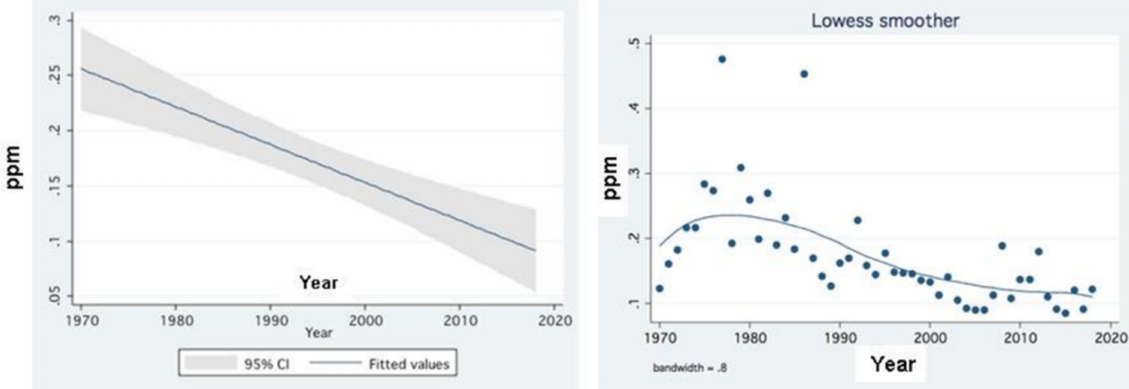
Figure 4. Temporal changes (1970–2018) in annual averages of total phosphorus (TP) concentrations (ppm) in Jordan waters: Left : linear regression (95% CI). Right : LOWESS smoother plot (bandwidth = 0.8).